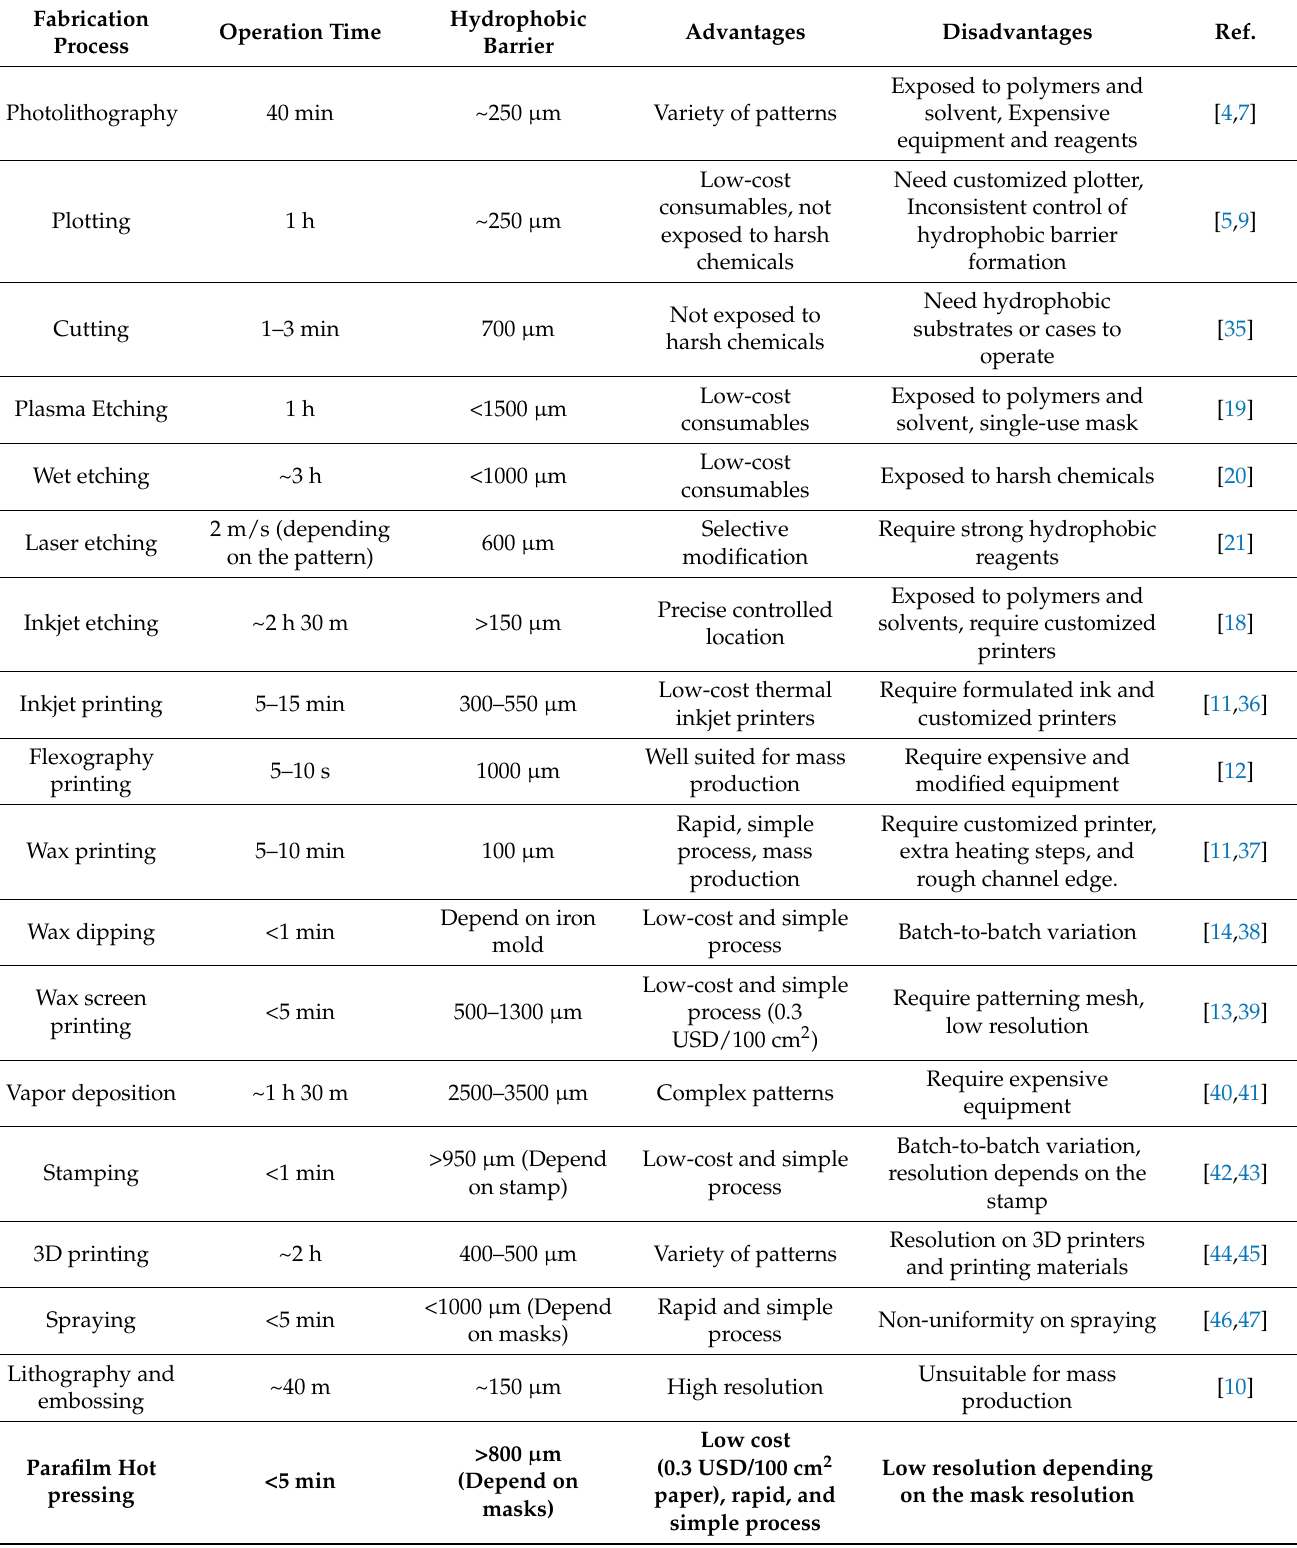
Table 1. Comparison of paper-based analytical devices fabrication